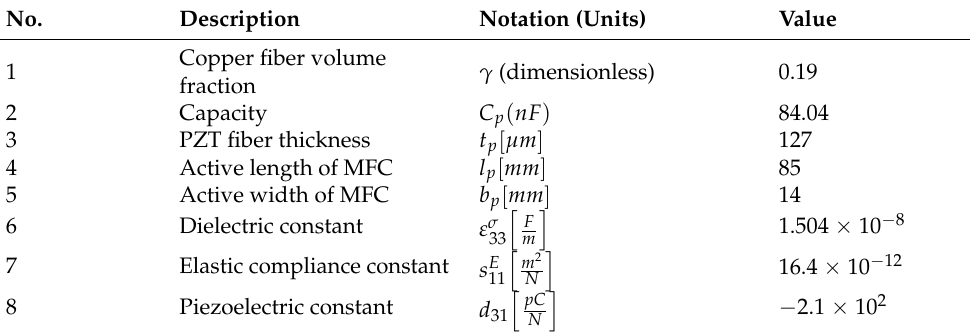
Table 2. The tested MFC transducer material properties and geometrical parameters